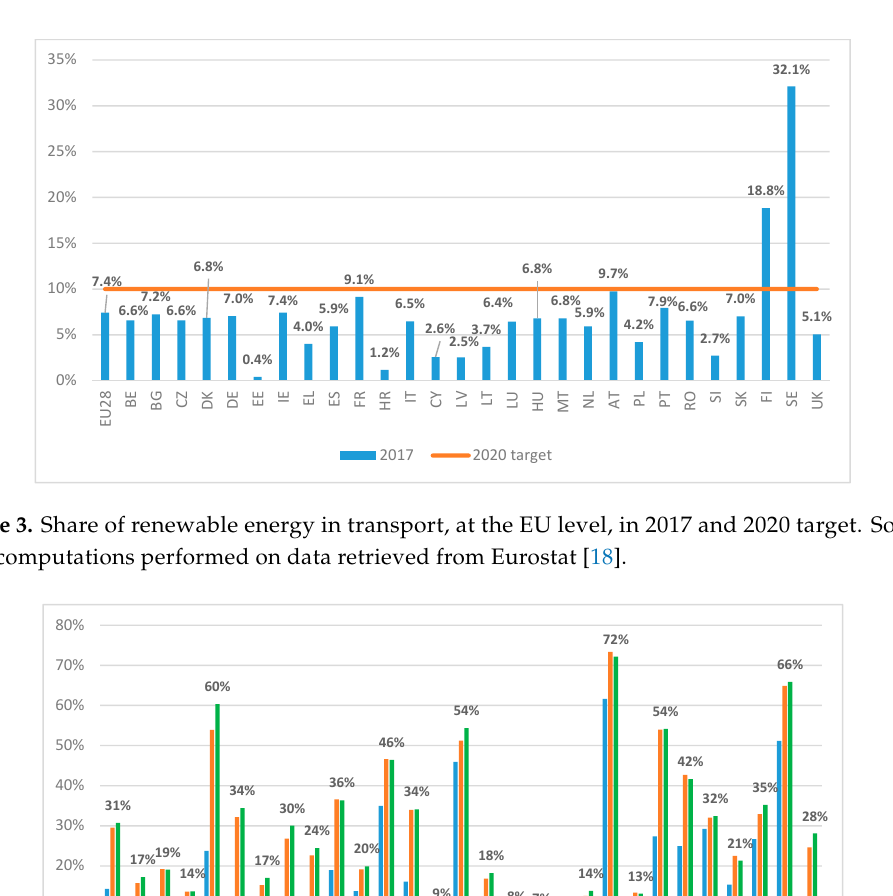
Figure 4. Renewable energy source (RES) shares of electricity in EU member states. Source: own computations performed on data retrieved from Eurostat [18].